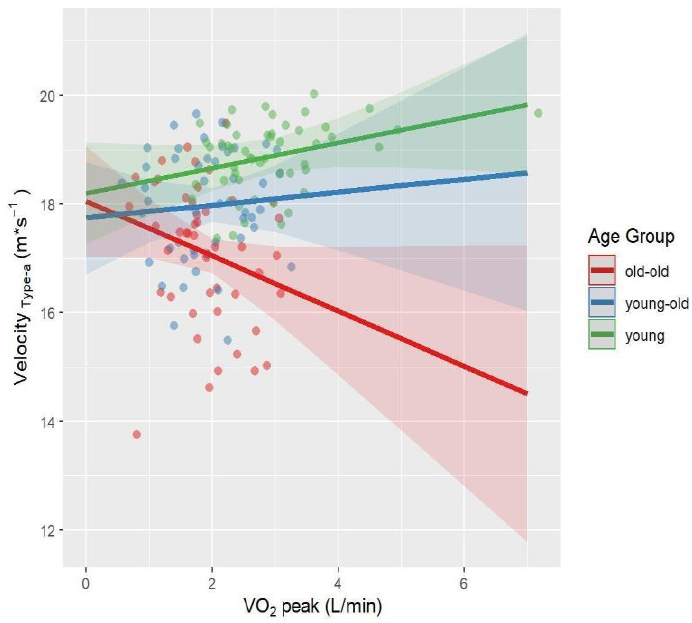
Figure 5. Interaction effect between age and VO 2 peak on Velocity Type-a after controlling for BMI and sex. The fit lines represent the trend of the data for subgroups. Green: young adults, Blue: young-old adults, Red: old-old adults. Young and young-old adults drove faster with higher VO 2 peak, while old-old adults drove slower.